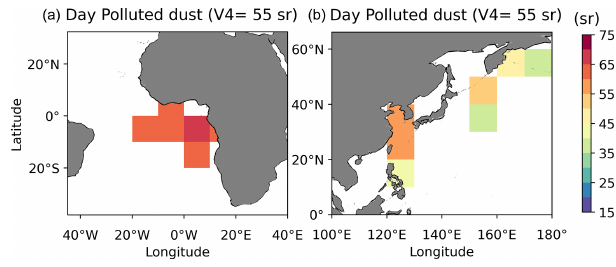
Figure 15. Daytime CALIPSO–SODA daytime lidar ratio for pol- luted dust classified from 5 and/or 20km spatially averaged data for the two regions with available observations: eastern Atlantic (a) and northwest Pacific (b) . Values are reported for grids constructed with at least 20